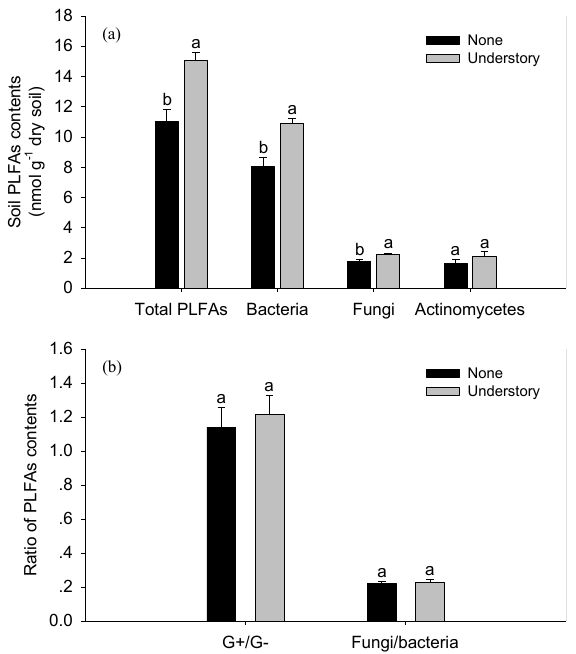
Figure 2. Soil phospholipid fatty acids (PLFAs) in the different understory vegetation treatments. Soil PLFA contents (a) ; ratio of PLFA contents (b) . G + / G − : ratio of gram positive bacteria to gram negative bacteria; F / B: ratio of fungi to bacteria. Different lower- cases represent significant differences among the None and Under- story treatments ( P < 0 . 05). Data are the means ± standard errors. The same abbreviations apply to Fig.